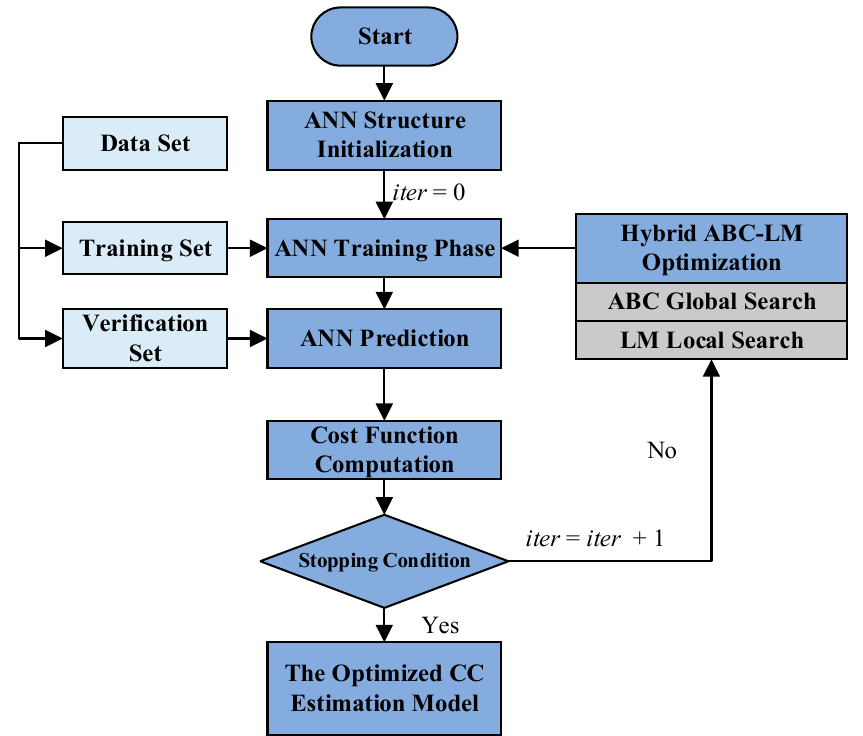
Figure 5. The proposed artificial bee colony Levenberg–Marquardt artificial neural network (ABC- LM-ANN) for compression coefficient (CC)